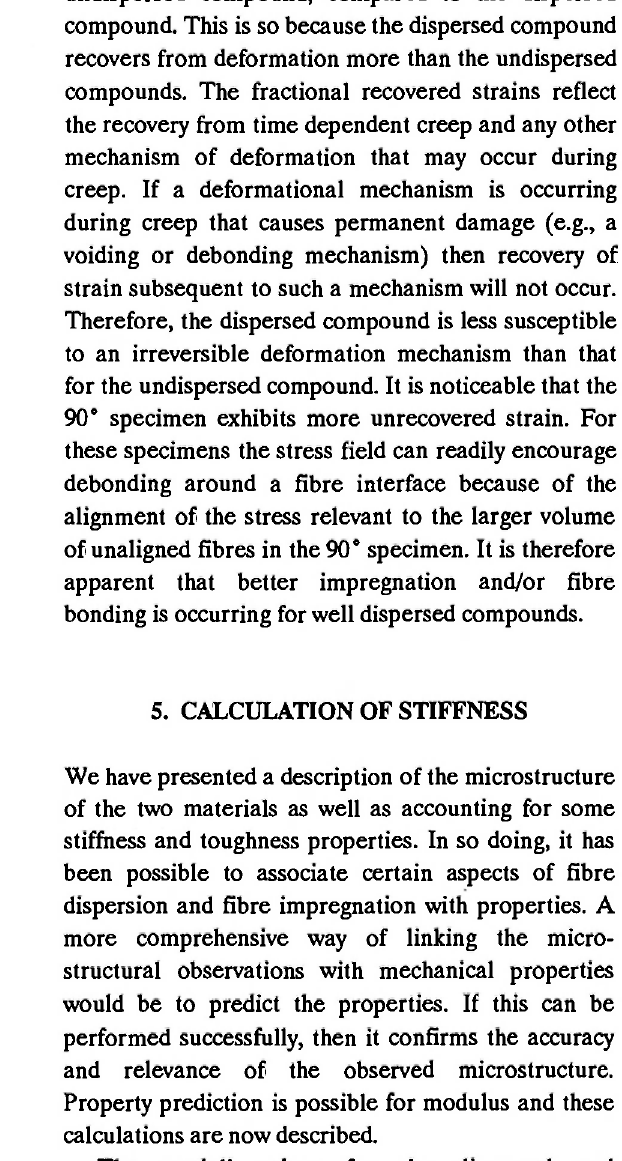
Table 11: Material properties used in the